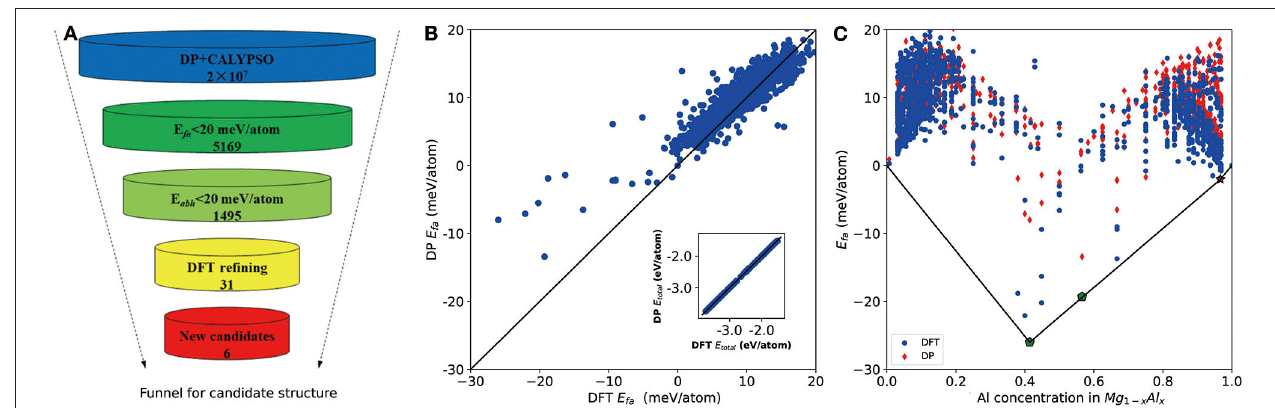
FIGURE 2 | (A) The funnel used for screening candidate structures of aluminum–magnesium (Al–Mg), the intermetallic compound via Deep Potential (DP) model. E fa stands for formation energy and E abh labels energy above the convex hull. (B) Scatter plot of the formation energy calculated by density functional theory (DFT) and DP for potentially candidate structures. The inset shows relationship between average energy calculated by DFT and DP. (C) The formation energy as a function of molar fraction of Al atom for different Mg–Al phases where solid line denotes the convex hull constructed by DFT results. The formation energies calculated by DFT are marked by blue circle and DP ones are marked by red diamond. All of known structures from materials project are re-optimized and directly used to construct the convex hull. Pentagon indicates the stable experimental phases and star labels new stable phase.